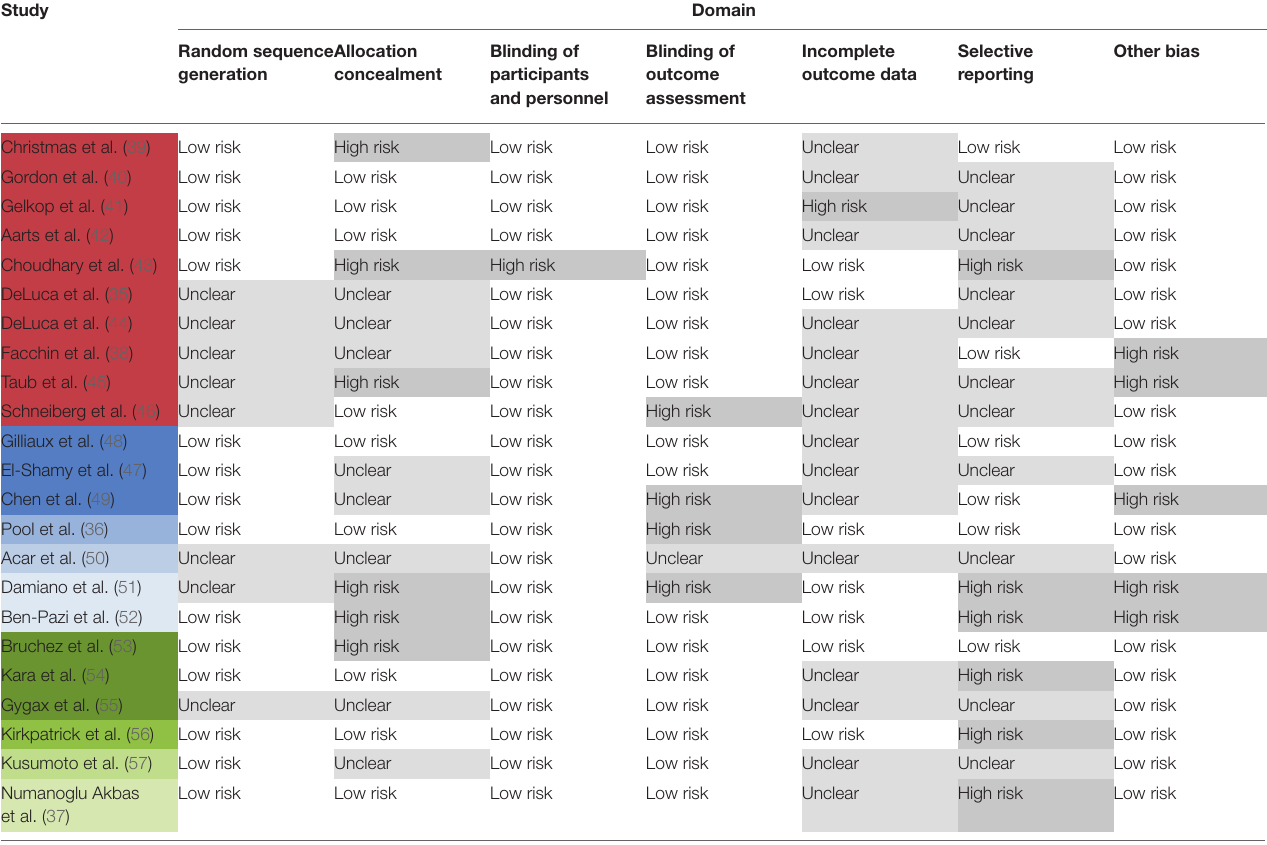
TABLE 4 | Cochrane risk of bias assessment of included